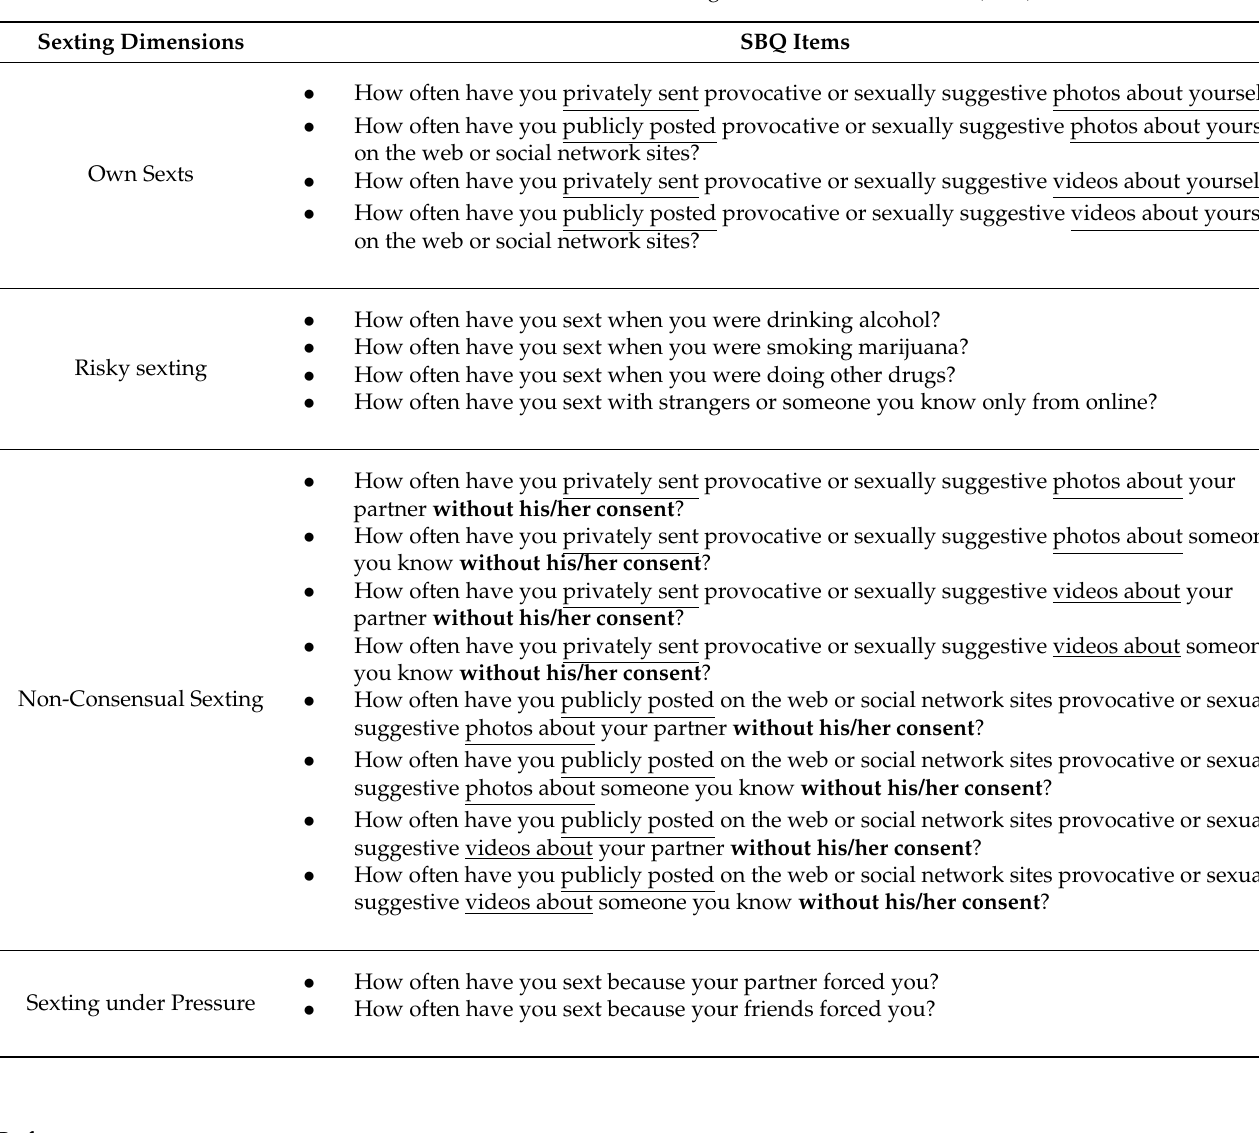
Table A1. Items of Each Dimensions of Sexting Behaviors Questionnaire